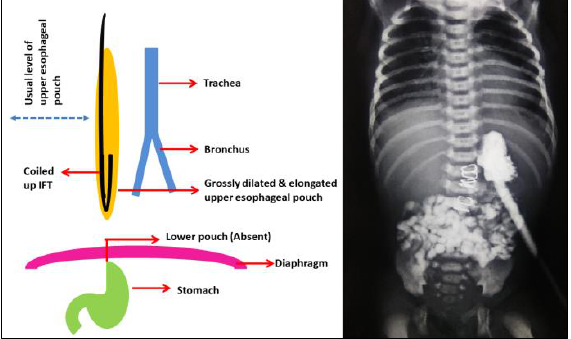
Figure 2: Diagrammatic representation (Case 1) showing Kluth type I3.Postoperative contrast study through gastrostomy shows absence of lower esophageal pouch.